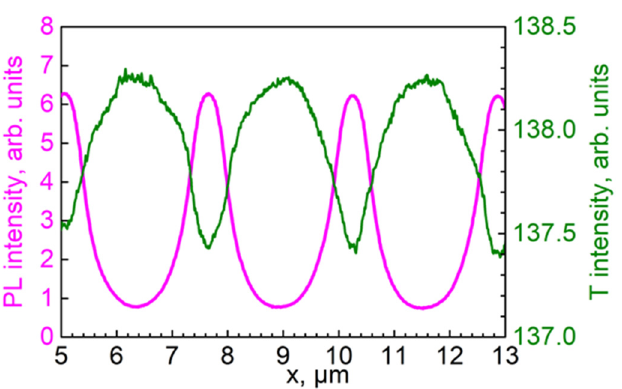
Figure 5. Intensity profiles of PL (magenta; excitation wavelength = 405 nm; acquisition range = 550–650 nm) and transmitted light (T, olive; 405 nm) along the holographic grating vector resulting from the data presented in Figure 4.